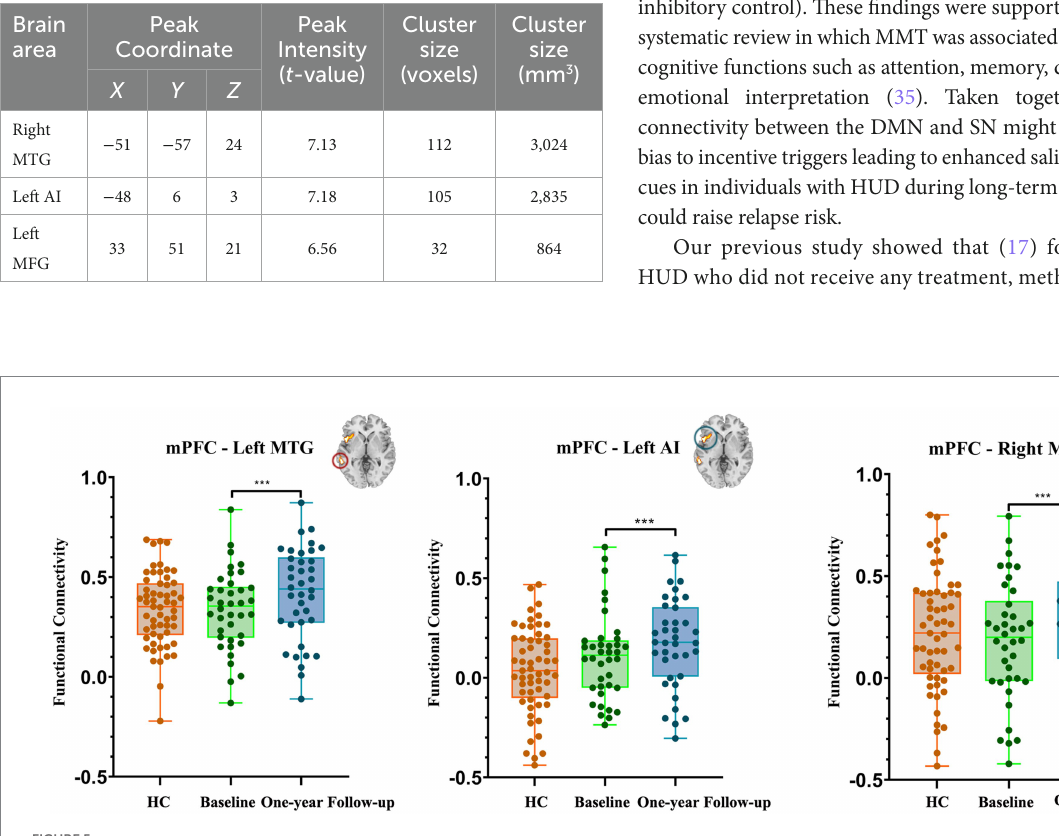
FIGURE 5 Bar chart of the post-hoc results related to the changes in functional connectivity based on mPFC after one-year follow-up. The data of the HC group is presented as control data (HC, healthy controls; mPFC, medial prefrontal cortex; MTG, middle temporal gyrus; AI, anterior insula; MFG, middle temporal gyrus. *** p <